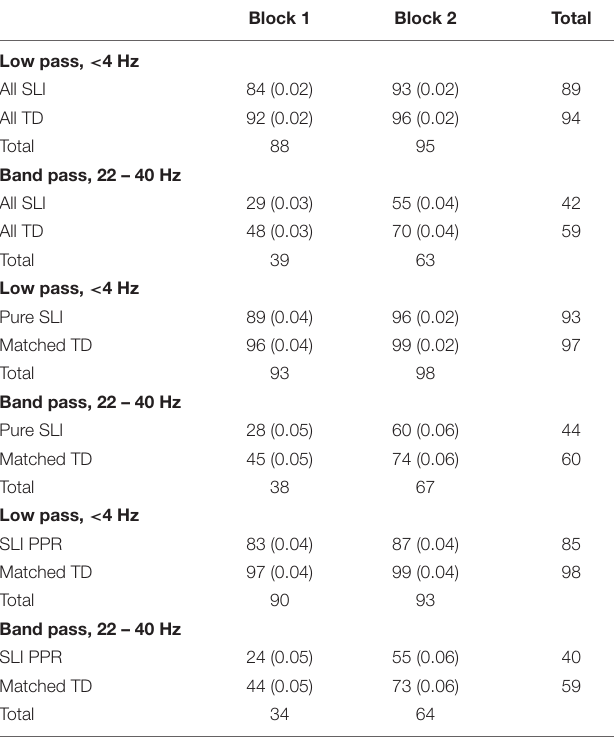
TABLE 7 | Recognition accuracy (% target rhymes identified) by presentation block in Experiment 2, with standard errors in